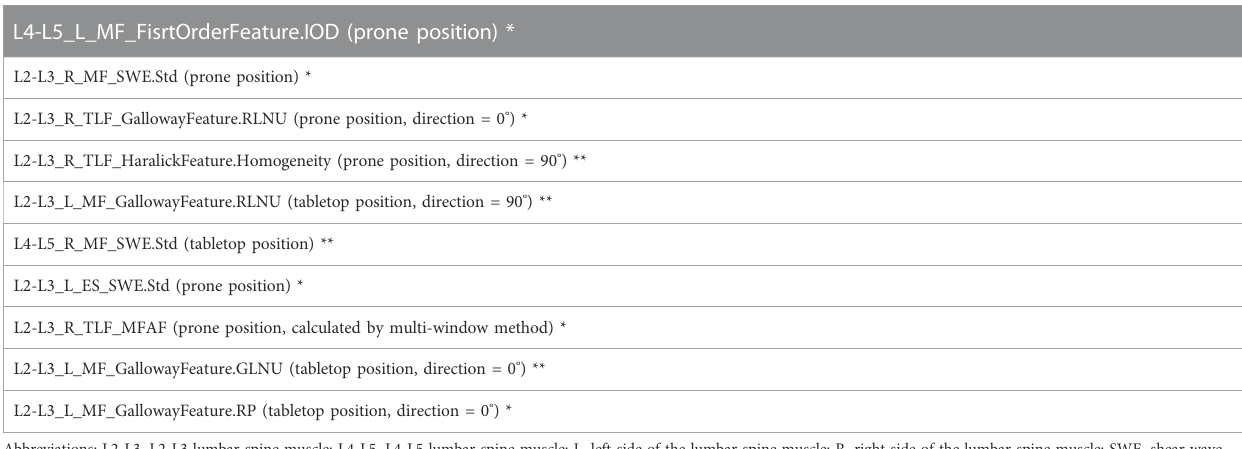
TABLE 6 Top 10 important features in the optimal feature set.